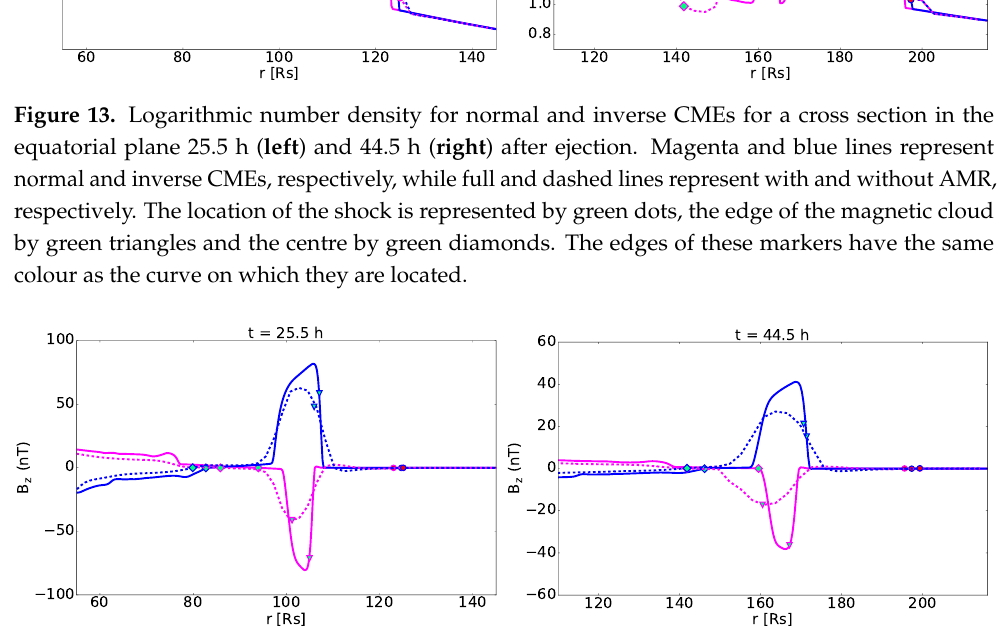
Figure 14. Same as Figure 13 but showing B z instead of the